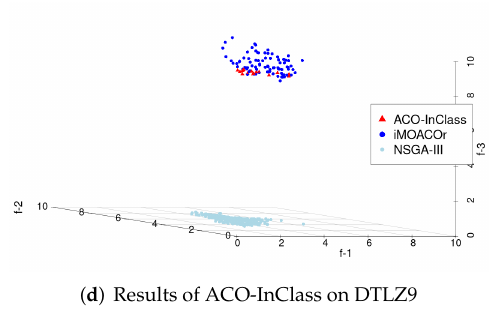
Figure 3. Results of ACO-InClass on some 3-objective